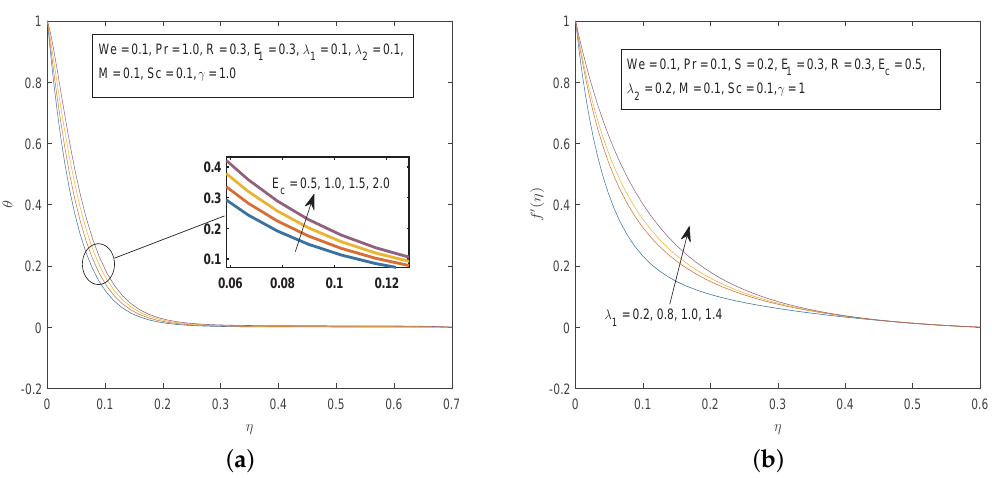
Figure 12. ( a ) Effects of E c on θ and ( b ) Effects of λ 1 on f (cid:48) ( η )